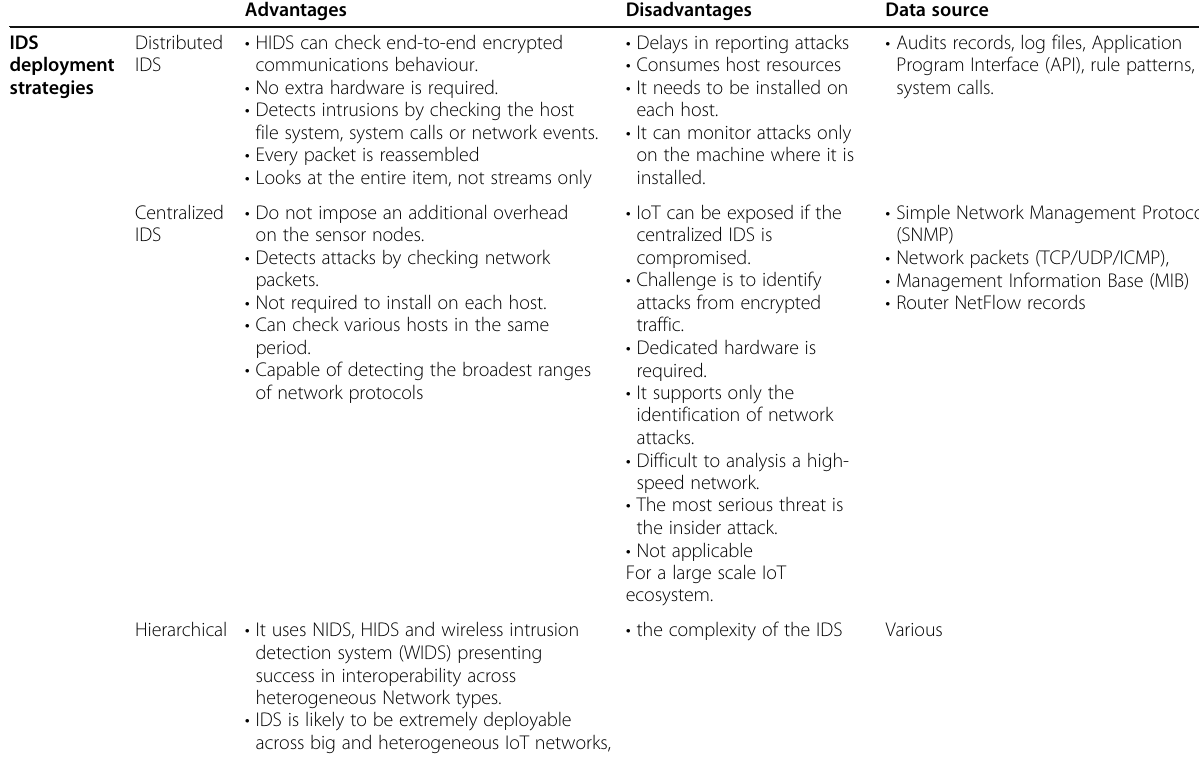
Table 6 Comparison of IDS deployment strategies based on their positioning Advantages